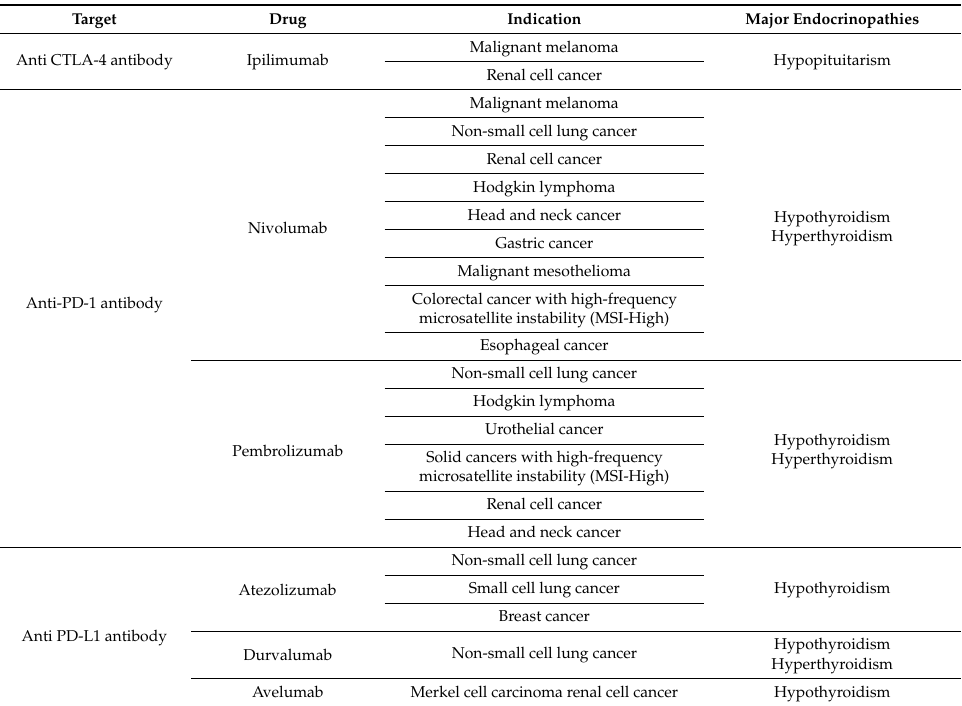
Table 1. Indication and major endocrinopathies of immune checkpoint inhibitors